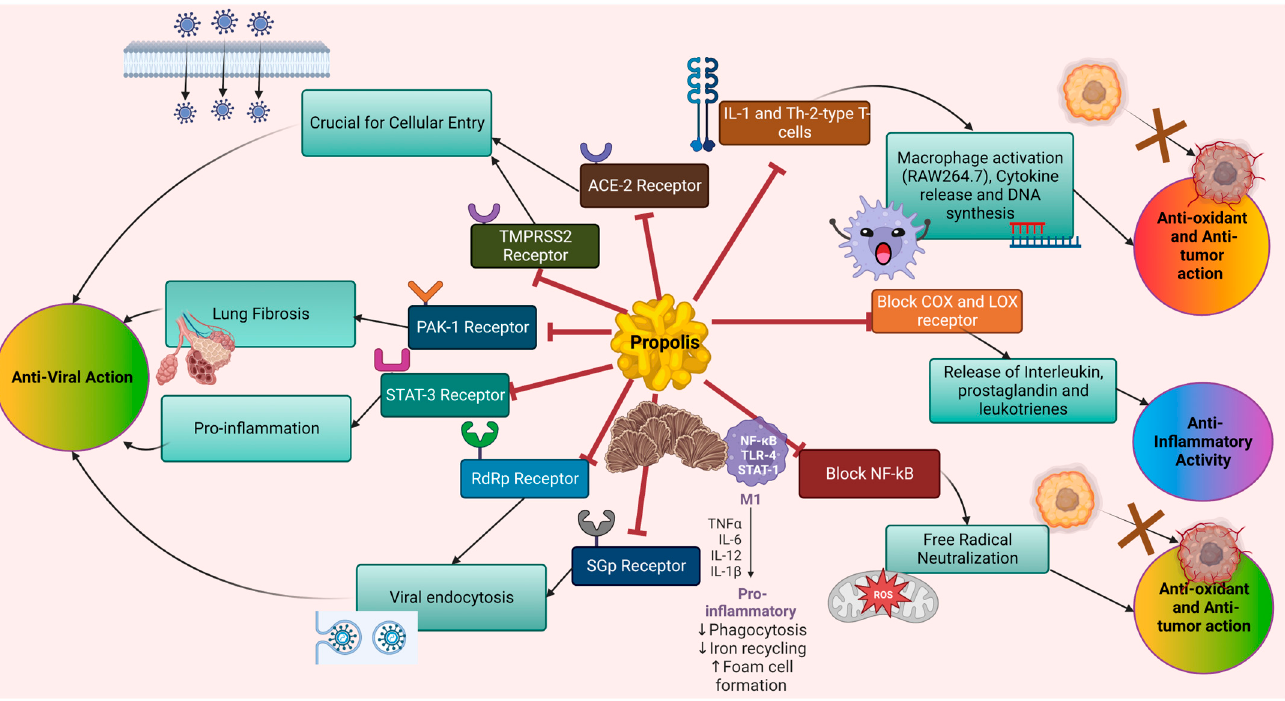
Figure 1. Propolis has potent antioxidant, antitumor, anti-inflammatory and antiviral activities. It inhibits various receptors that are responsible for the respective actions.